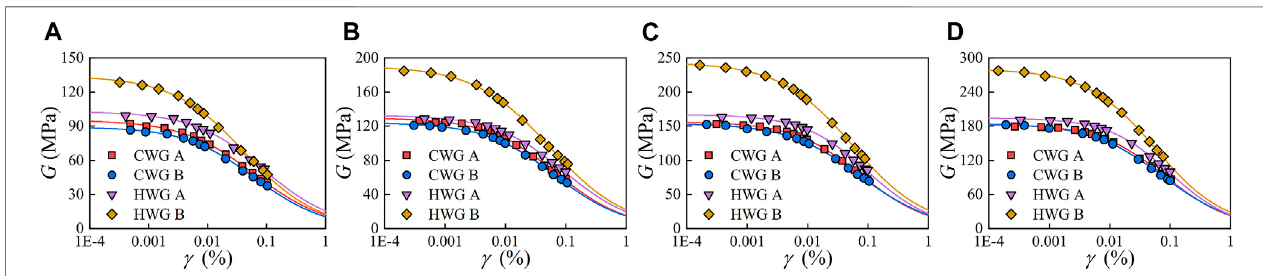
FIGURE 8 | Relationship between shear modulus G and shear strain γ for specimens at different effective consolidation pressures: (A) 200 kPa; (B) 300kPa; (C) 400kPa; (D) 500 kPa. (Data points halved).